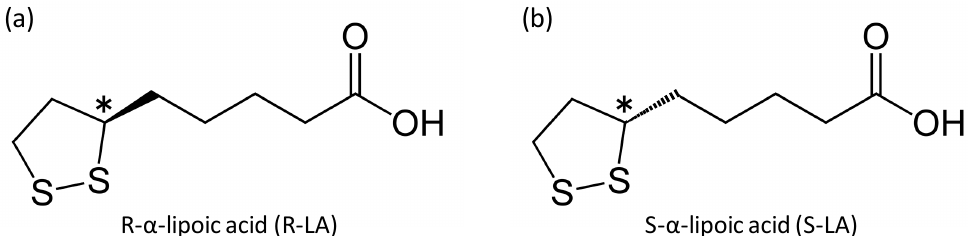
Figure 1. Chemical structure of R- α -lipoic acid ( a ) and S- α -lipoic acid ( b ). The chiral center is marked with an asterisk (*).